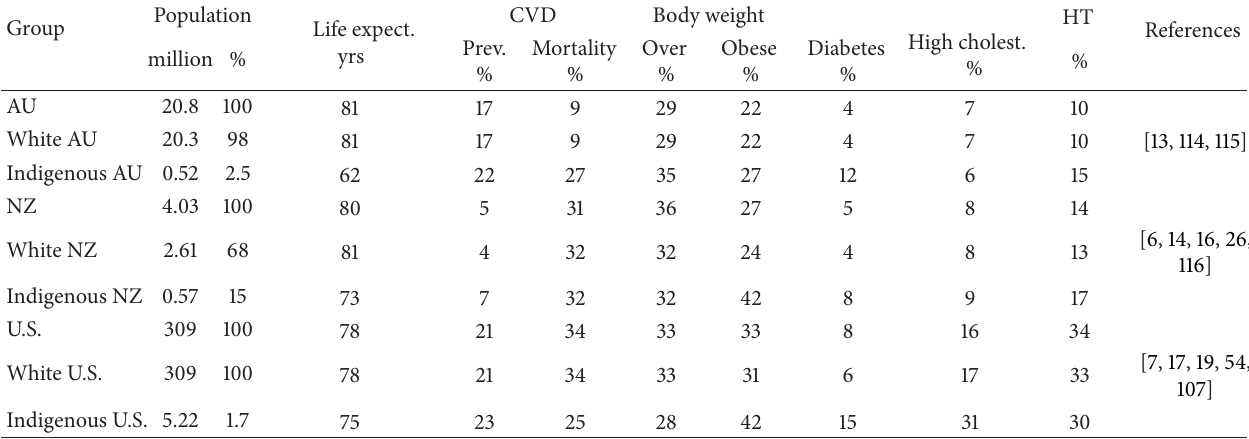
Table 1: Prevalence of cardio-metabolic risk factors among adults.